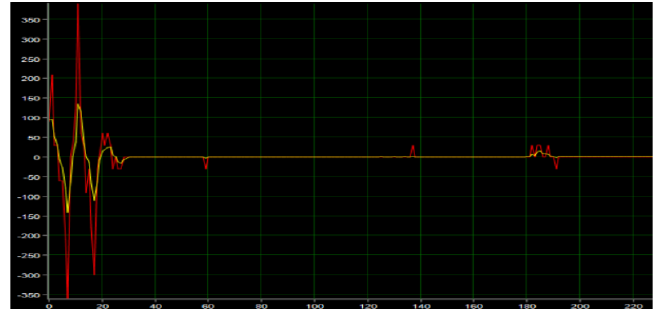
Figure 14. Speed loop test.